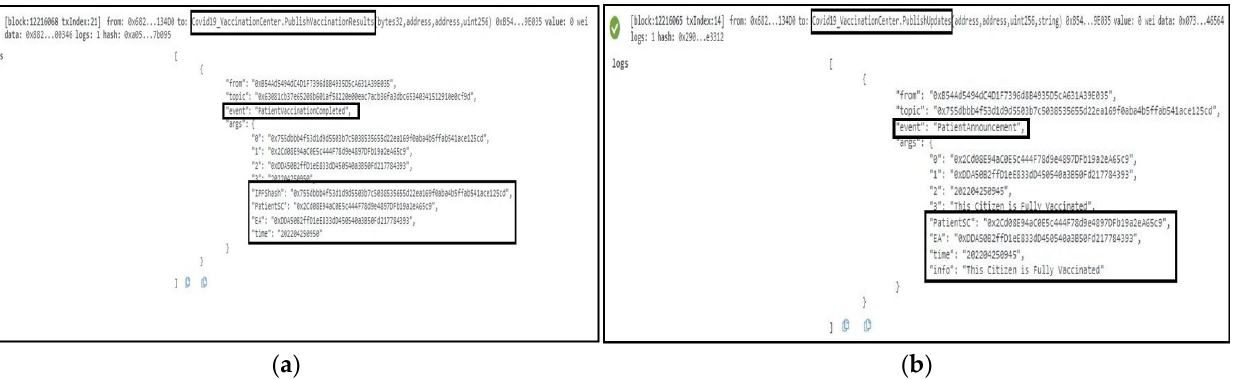
Figure 8. Logs of the deployment of Vaccination Center Smart Contract: ( a ) Vaccination results are published; ( b ) vaccination result is announced.